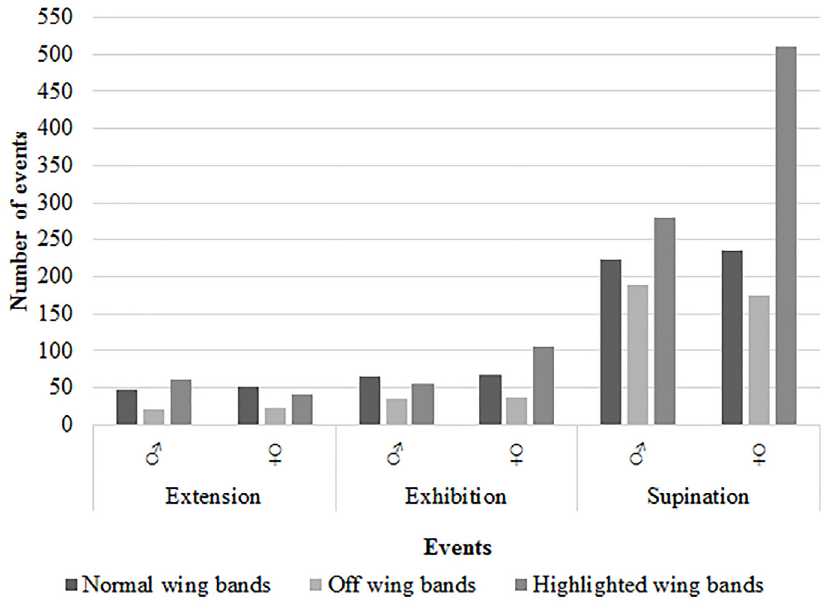
Figure 1. Number of events related to extension, exhibition and supination of Anastrepha fraterculus in different